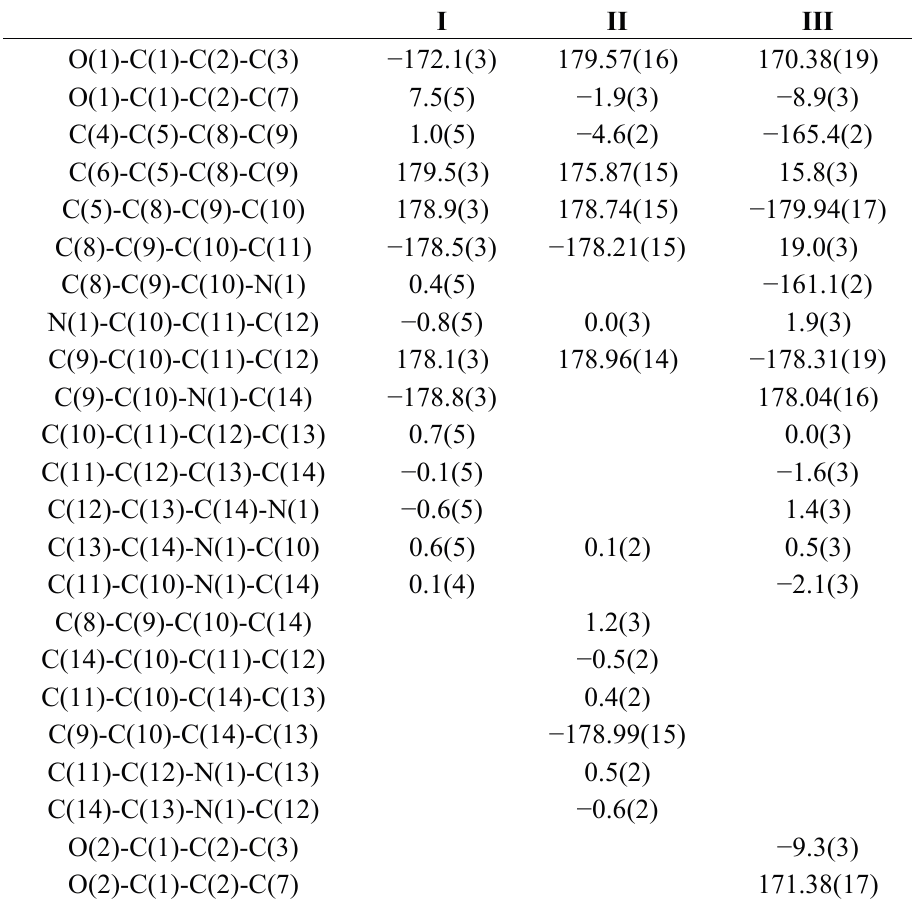
Table 4. Torsion angles (°) for compounds I , II and III